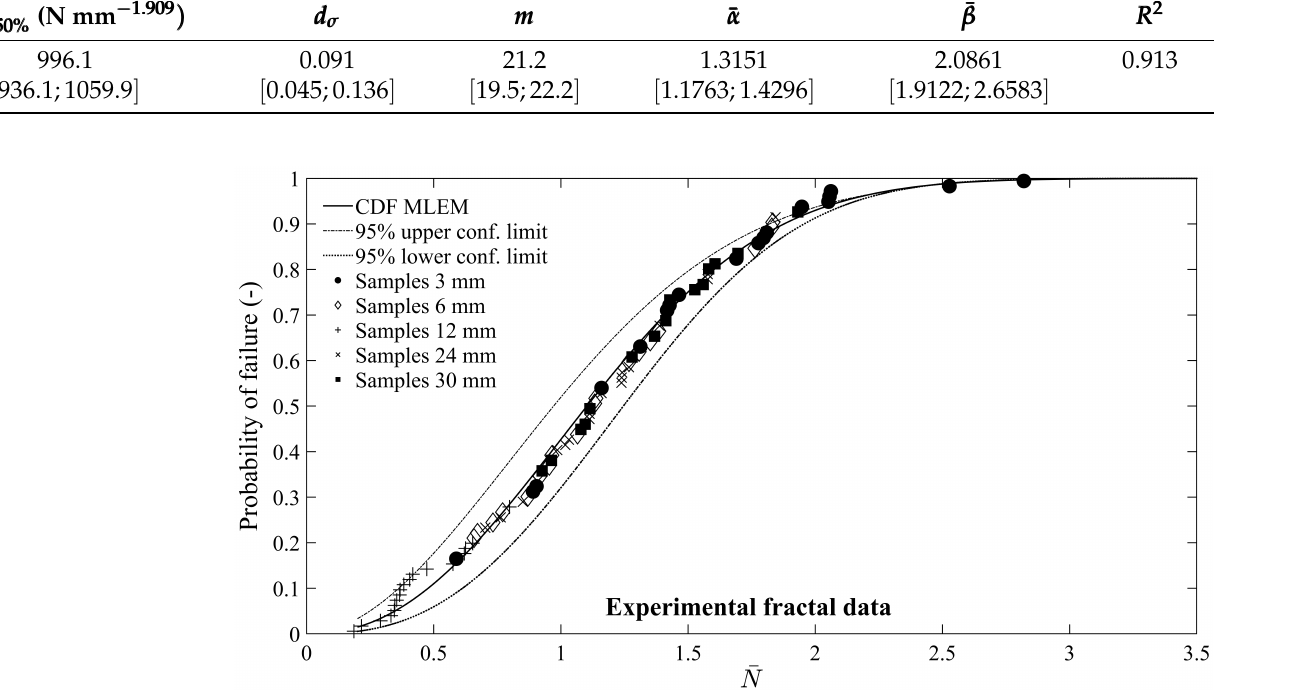
Figure 2. CDF for the experimental fractal data. Table 2. Goodness-of-fit statistics test results for the whole experimental